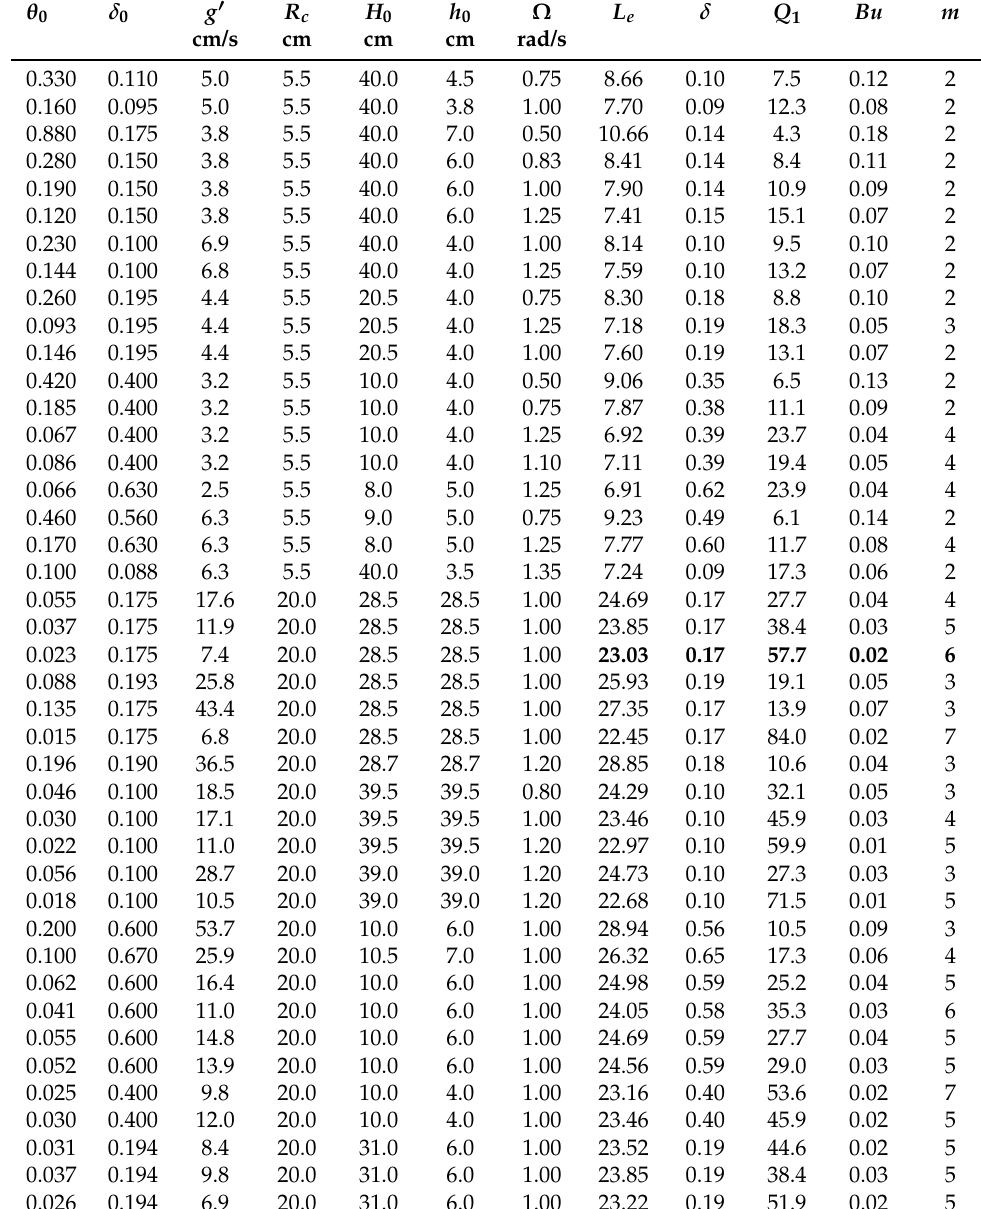
Table A1. Parameters of the laboratory experiments: experimental configuration are in the first 7 columns, estimated nondimensional parameters of the adjusted vortex in the next 4 columns, and observed most unstable mode number in last column. Symbols are explained in the text. Bold values are for the experiment shown in Figure